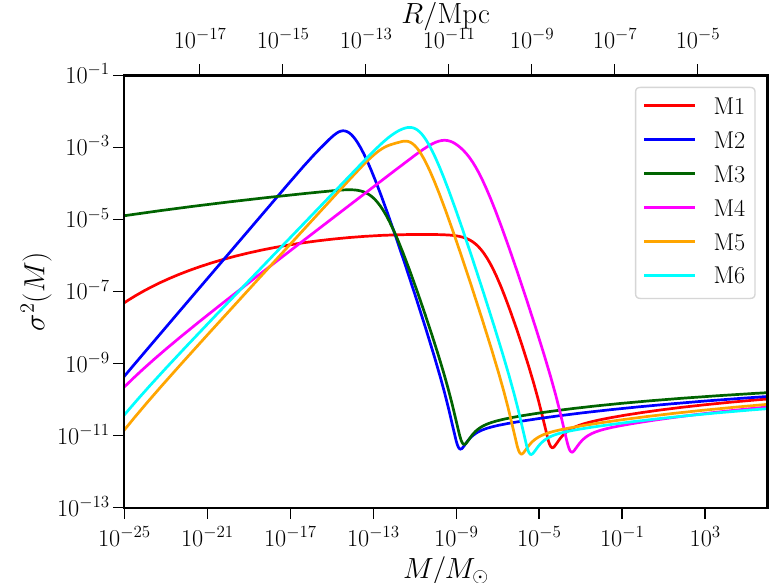
Figure 6. The variance σ 2 ( M ) of the density fluctuations has been plotted as a function of the mass M of the PBHs for the inflationary models M1 to